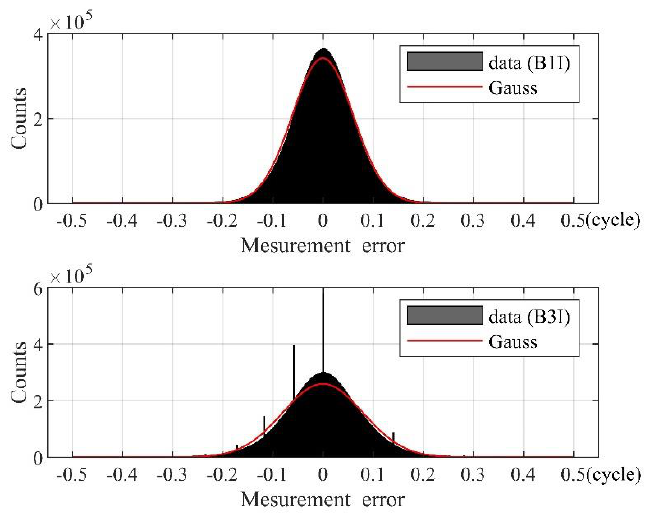
Figure 13. Fitting curve of the carrier-phase measurement error distribution and Gaussian distribution.